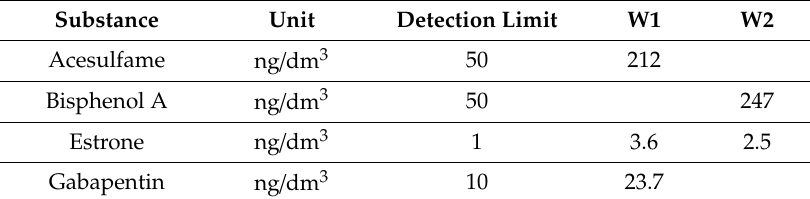
Table 13. Substances detected above the detection limit of two groundwater sources—Hnevkovice village wells (Figure